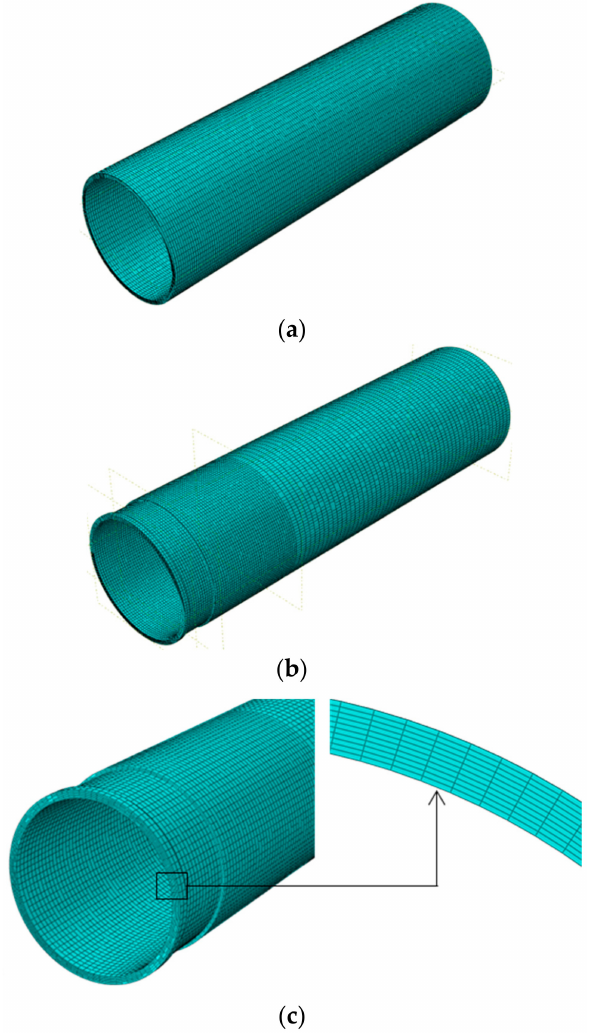
Figure 4. A sample of a finite element model mesh: ( a ) Non-corroded model; ( b ) Corroded model; ( c ) Transverse axis